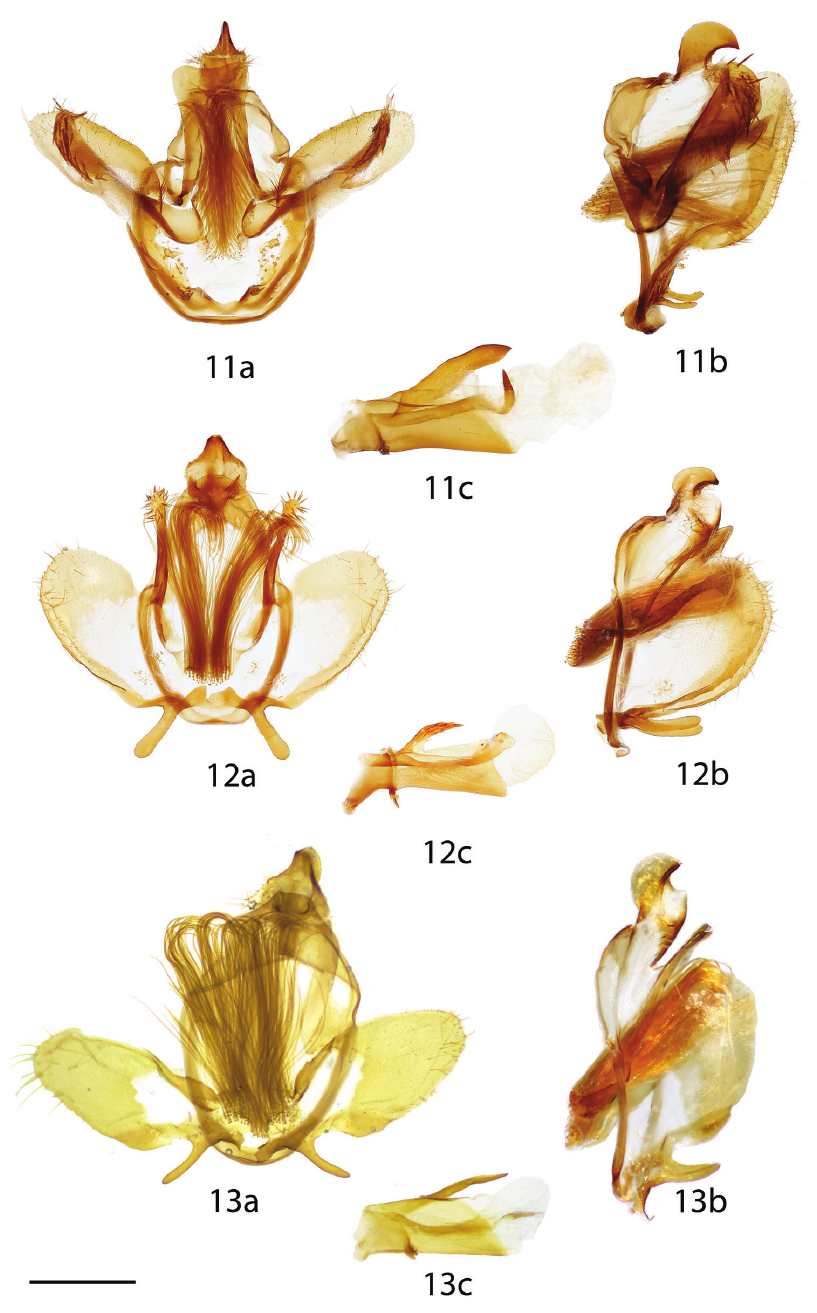
Figures 11–13. Tarema male genitalia, a ventral b lateral c phallus lateral. 11 T. rivara , Brazil, Distrito Federal, Estação Florestal, Cabeça do Veado, 1100 m, St Laurent diss.: 3-14-16:7 (CNC) 12 T. fuscosa , Brazil, Santa Catarina, St Laurent diss.: 2-26-16:7 (CUIC) 13 T. bruna holotype, Brazil, São Paulo, Alto da Serra [Paranapiacaba], NHMUK010402168 genitalia prep. [13b horizontally flipped] (NHMUK). Scale bar: 1